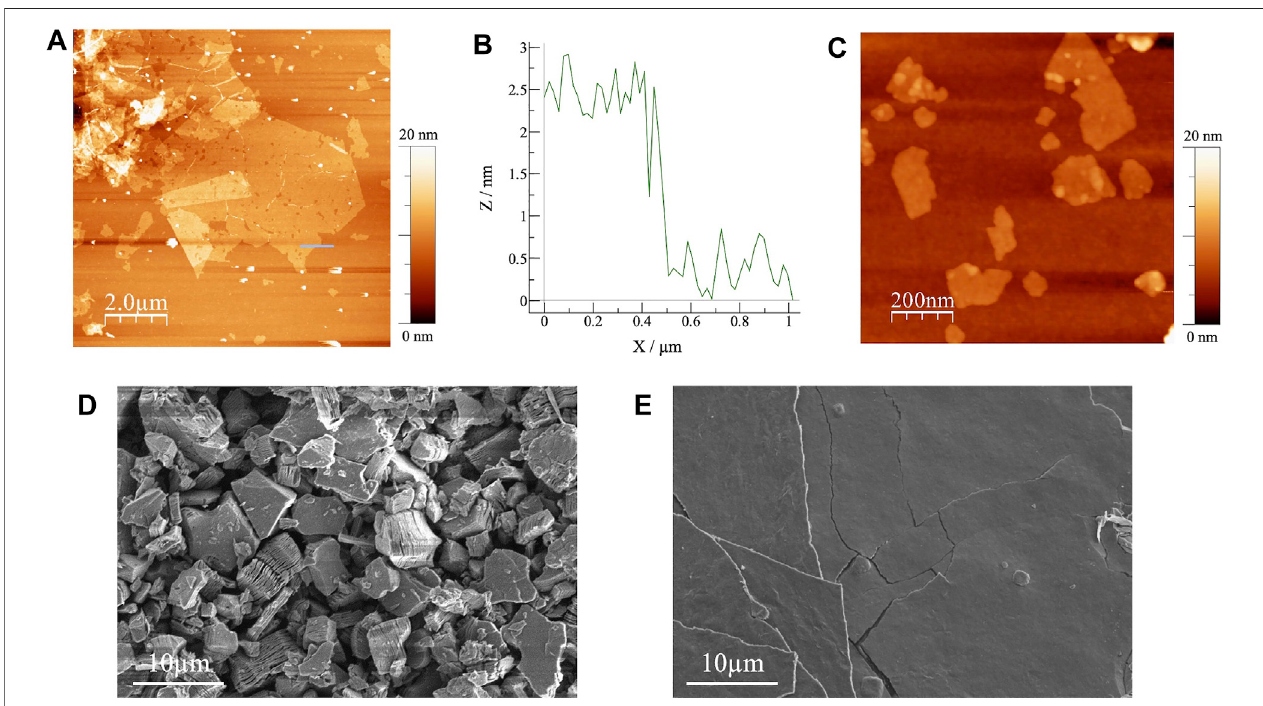
FIGURE 2 | (A) AFM image and (B) the corresponding height pro fi le of exfoliated Ti 3 C 2 T x MXene without sonication; (C) AFM image of exfoliated Ti 3 C 2 T x MXene prepared by the sonication treatment; SEM images of (D) pristine and (E) exfoliated Ti 3 C 2 T x MXene.